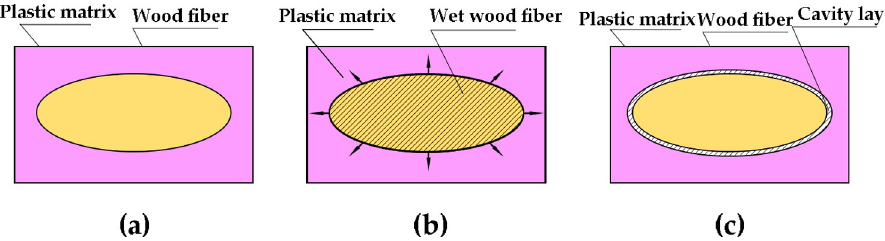
Fig 1. Damage principle of moisture in WFs to wood plastic composites, (a) dry WPC, (b) Moisture evaporation of WF, (c) Formation of cavity layer after